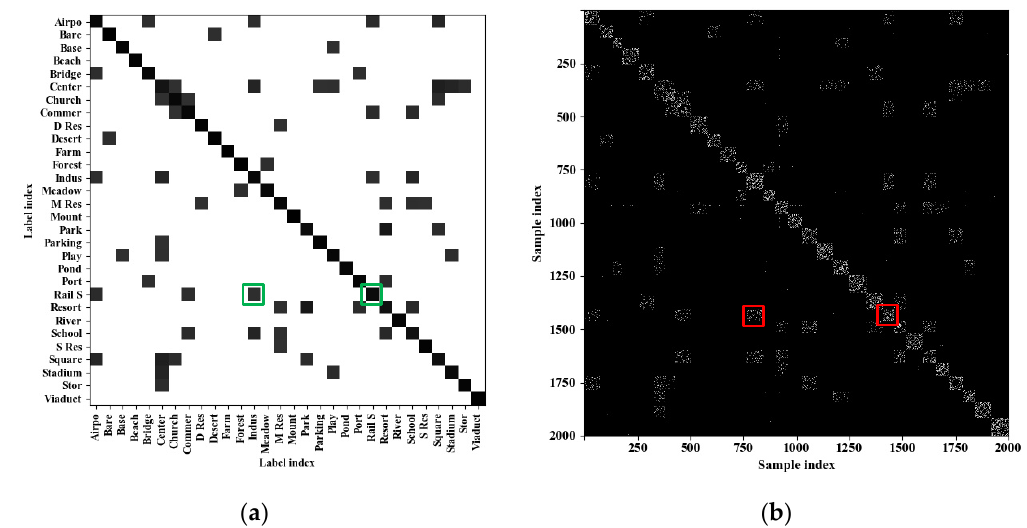
Figure 7. Visualizations of ( a ) the global label correlations G and ( b ) the affinity graph A . Because the AID-0.2 dataset is comprised of 2000 training samples that cover 30 scene classes, A is a 2000 × 2000 matrix and G is a 30 × 30 matrix. The dark and light colors stand for low and high values, respectively. The dark elements in G indicate low label differences, and the light elements in A represents strong neighboring relations.